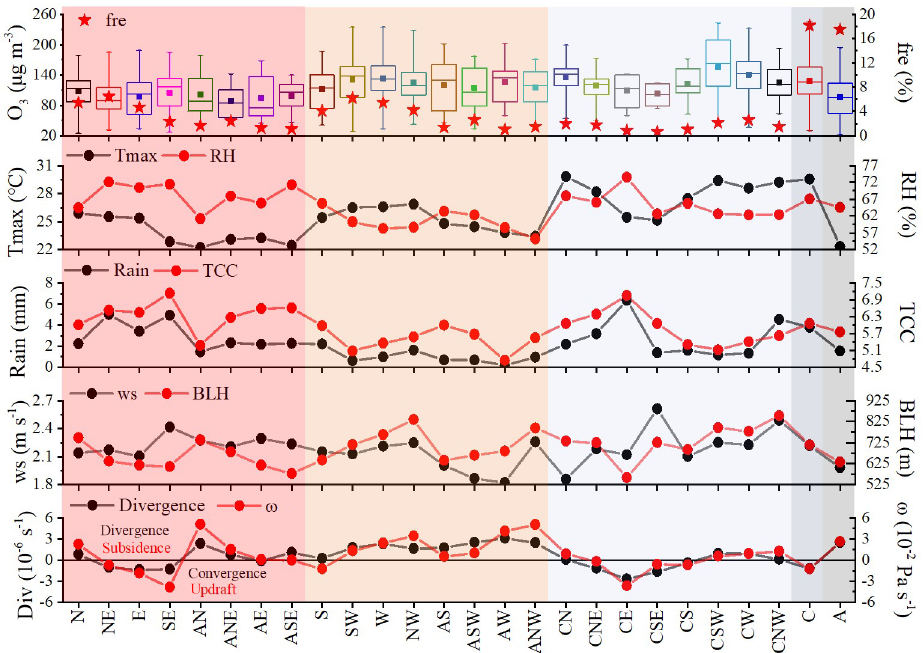
Figure 5. Box chart of domain-averaged MDA8 O 3 concentrations, occurrence frequency of weather types (fre), and mean values of meteo- rological factors in 26 weather types during April–October 2013–2017. In the box chart, the solid square indicates the mean, the horizontal lines across the box are the averages of the first, median, and third quartiles, respectively, and the lower and upper whiskers represent the 5th and 95th percentiles, respectively. The pink, orange, light blue, dark blue and black areas represent the weather categories N–E–S direction, S–W–N direction, LP (low-pressure-related weather patterns), C (cyclone) and A (anticyclone),